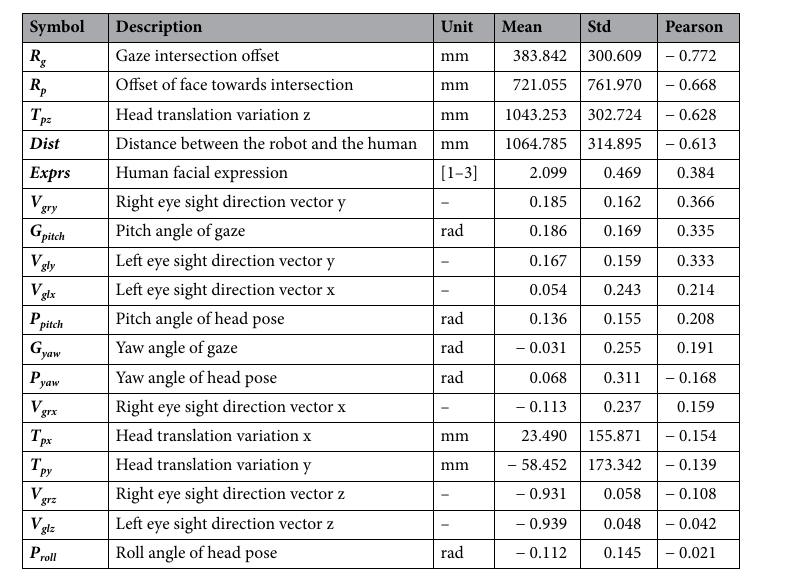
Table 3. Details of feature set data, including description, unit, mean, standard deviation and Pearson